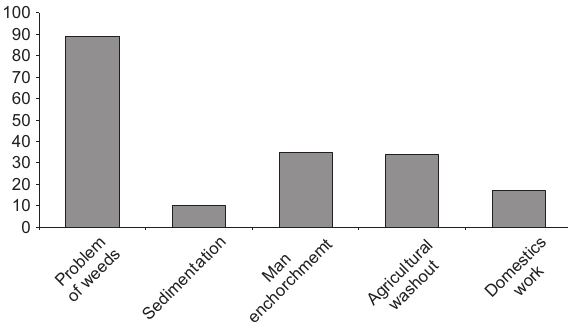
Fig. 2. The chart shows the main problem of beel water from